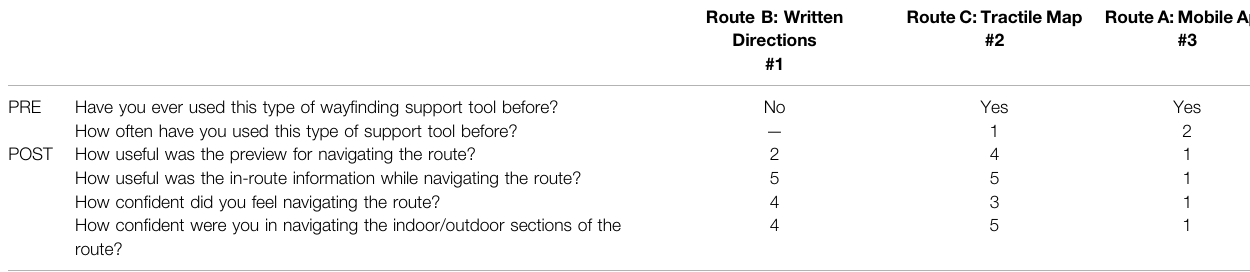
TABLE 3 | Responses of the participant to the pre- and post-route questions for each of the three way fi nding